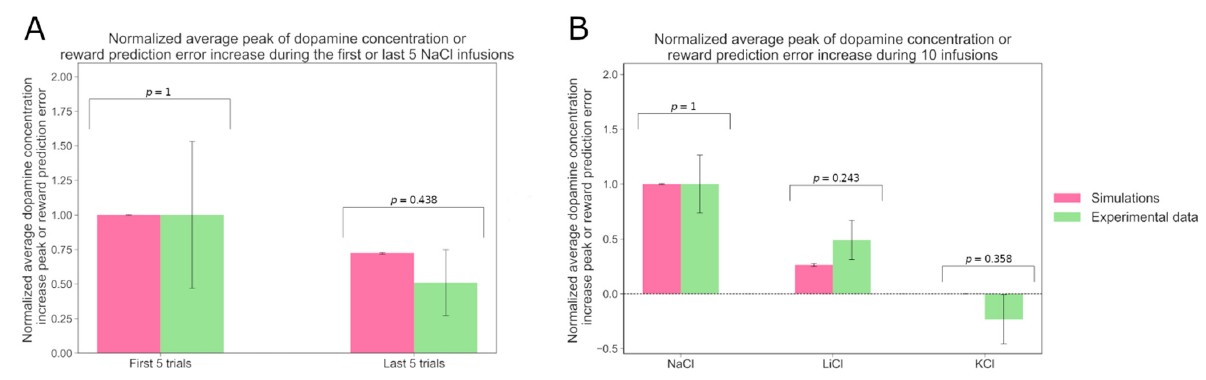
Figure 3. The model accounts for experimental data on dopamine dynamics. ( A ) Comparison of the sum of the dopamine concentration increase during the infusion period, averaged over 6 or 5 rats, and averaged over the first 5 or last 5 of a series of 10 intraoral NaCl infusions, as reported by Cone et al. in 2016 (in green), with the average RPE during the first 5 or last 5 of 10 successive simulated infusion trials, averaged over 6 or 5 rats (in pink). ( B ) Comparison of the sum of the dopamine concentration increase during the infusion period, averaged over 6 or 5 rats, as reported by Fortin and Roitman in 2018 (in green), with the sum of the RPE during ten simulated infusion trials, averaged over 6 or 5 rats (in pink).